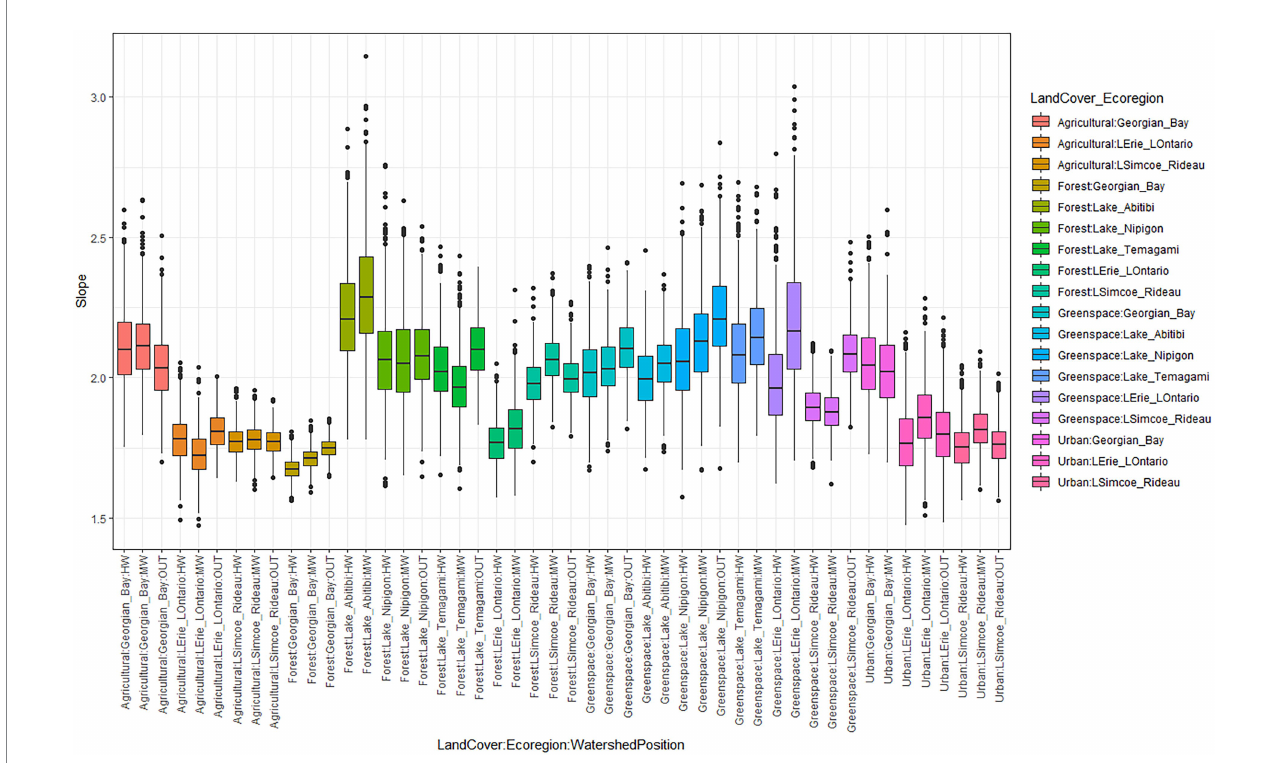
FIGURE 3 Boxplots showing the effect of Ecoregion, land cover type and watershed position on